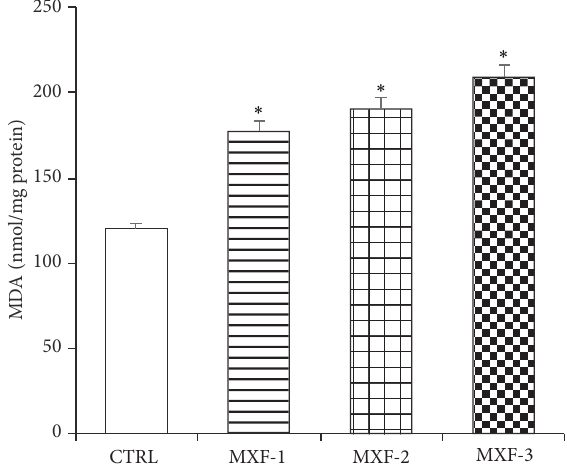
Figure4:InfluenceofMXFonthehepaticmalondialdehyde(MDA) level. Values represent the mean ± SD of six replicates. ∗ Significantly different from control ( 𝑃 < 0.05